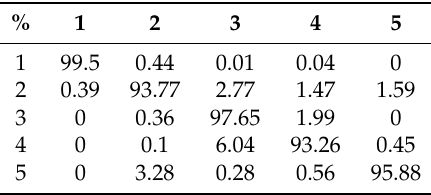
Table 7. The Confusion Matrix of